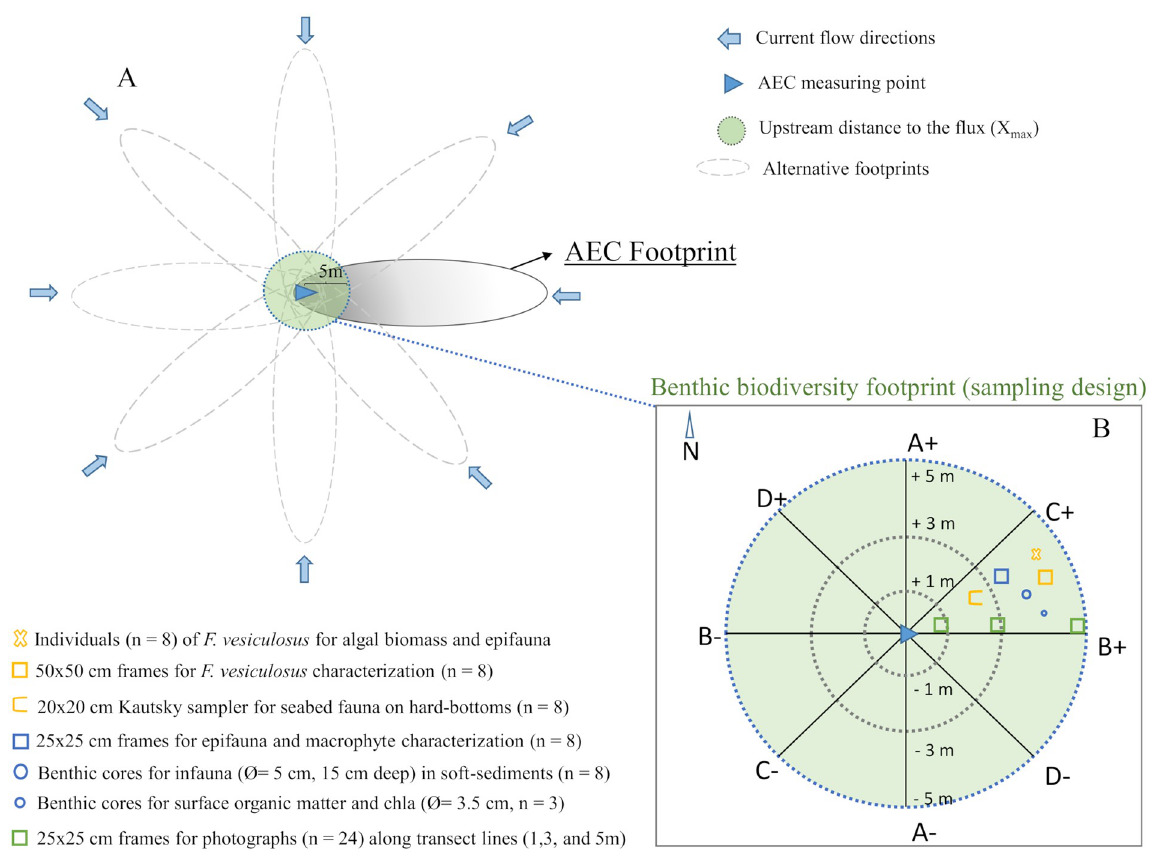
Fig 3. Schematic illustration of the AEC footprint and biodiversity sampling area. (A) Diagram from above showing the AEC footprint areas determined by different flow directions. The length, width and total area of the AEC footprints for all the habitats are shown in Table 1. The circular biodiversity footprint (80 m 2 , r = 5 m) was superimposed to the AEC footprint ensuring that the maximum flux contribution measured in all the habitats (X max = 5 m) was covered. The grey scale shows a theoretical gradient of the benthic contribution to the flux registered within the footprint area (darker grey implies higher contribution closer to the device). (B) Illustration of the biodiversity footprint area displaying 8 equal wedge-sections for community characterization. Quantitative random samples (n = 8, one replicate sample per each of the 8 wedge- sections) of the main benthic organisms (v macrofauna, macrophytes and macroalgae) were collected (see